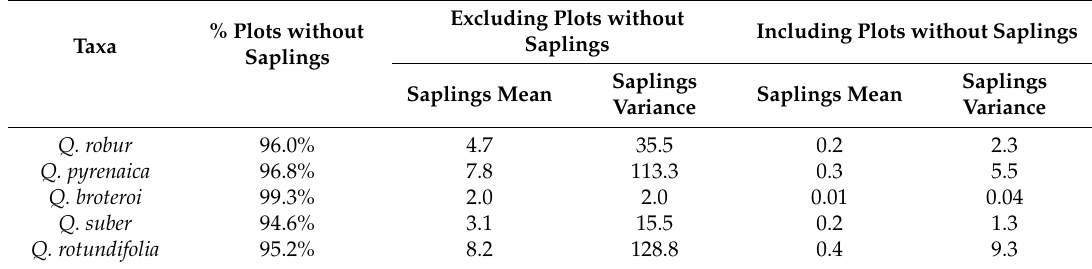
Table 3. Percentage of zeros, mean and variance of sapling by taxon.